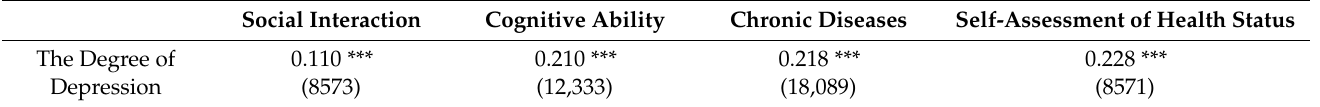
Table 5. Correlation between depression and other explanatory